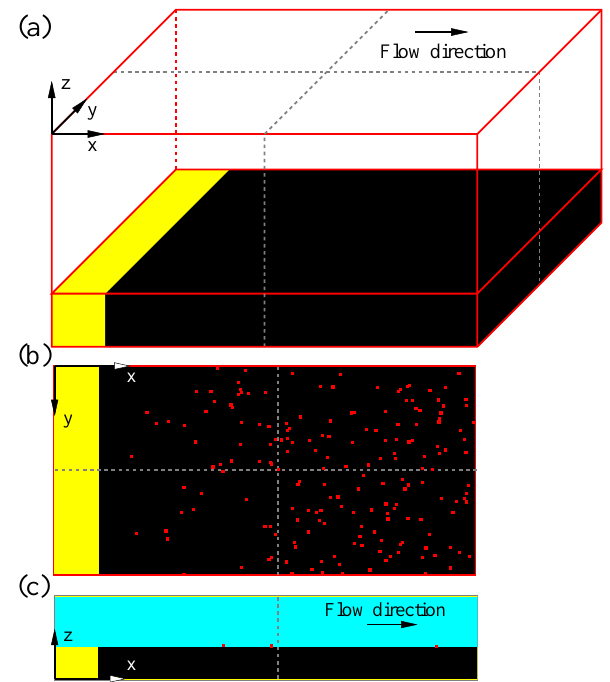
Fig. 2. The real-space virtual environment: (a) Initial condition to reproduce the experiments of Bagnold (1941). Fluids cells (cyan) and neutral cells (yellow) that make up the ceiling are transparent for the sake of readability. Immobile sedimentary cells are shown in black. (b) Distribution of mobile sedimentary cells (red) when the system reaches a dynamic equilibrium state. Note the increas- ing number of mobile sedimentary cells in the direction of the flow from the limit between the non-erodible and the erodible bed. (c) A vertical slice of cells in the direction of the flow. Note the presence of the ceiling that confines the flow.